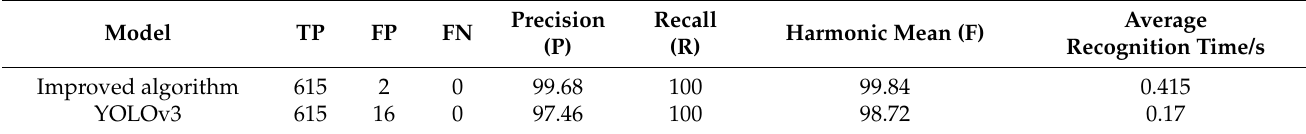
Table 2. Comparison of the combined algorithm and the YOLOv3 algorithm.